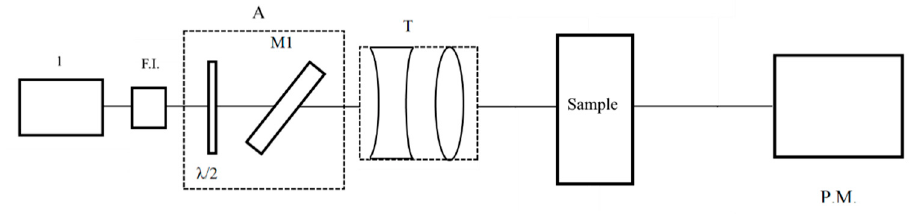
Figure 2. Schematic layout of the test stand.